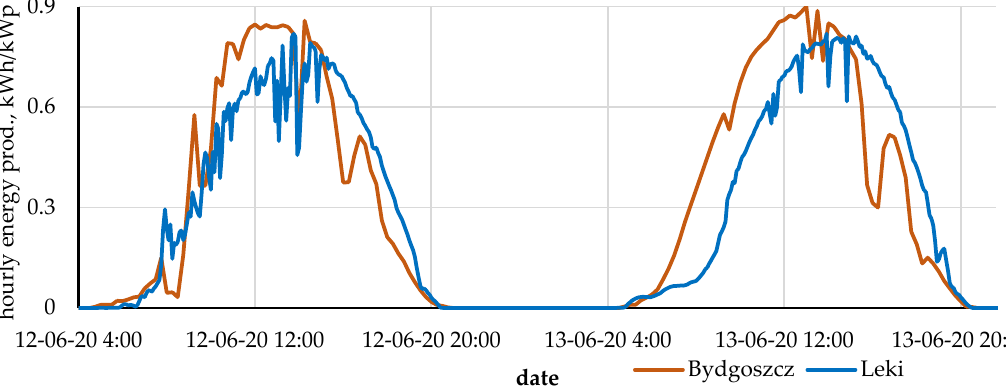
Figure 16. Comparison of the unit results of energy production from installations for 12 and 13 June. On 12 and 13 June, both locations recorded comparable high levels of insolation of 7 kWh/m 2 /day (Figure 15). On selected days, the installation in Leki produced 6.08 and 6.39 kWh/kWp, respectively, and in Bydgoszcz 6.20 and 7.03 kWh/kWp. In both cases, the two- sided installation generated more energy. In addition, on 13.06, the influence of a different direction of PV panel foundation was observed (SW30 for Leki, S45 for Bydgoszcz), the installation in Bydgoszcz reached the maximum hourly production of 0.87 kWh/kWp at around 1:00 p.m., while Leki 0.8 kWh/kWp in the period of 2:30 p.m. (Figure 17).